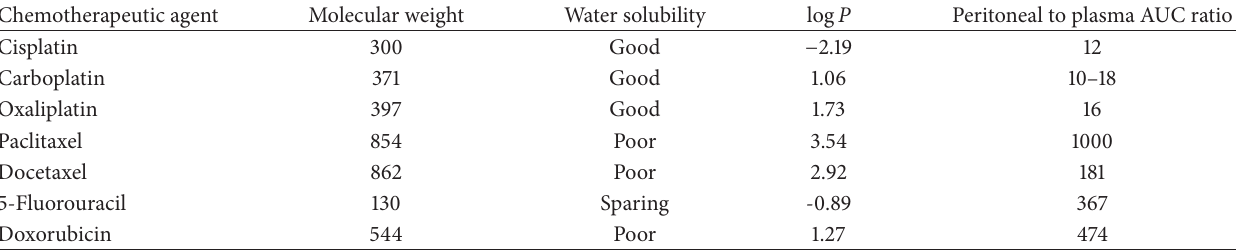
Table 1: Water solubility, the partition coefficient (log P ), and peritoneal to plasma drug area under the curve (AUC) ratio of intraperitoneal chemotherapeutic agents.